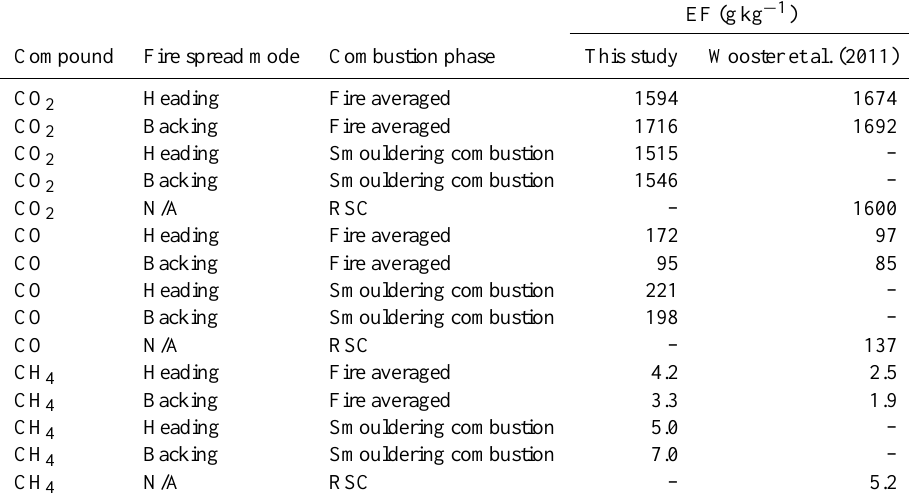
Table 3. Comparison of emissions factors with those of Wooster et al. (2011) for different fire spread modes and for residual smouldering